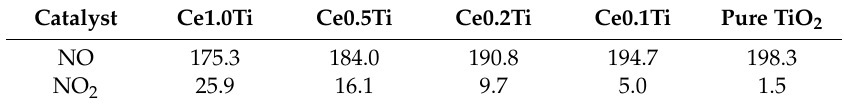
Figure 6. Simultaneous removal of Hg 0 and NO over various catalysts. ( a ) Ce1.0Ti; ( b ) Ce0.5Ti; ( c ) Ce0.2Ti; ( d ) Ce0.1Ti; ( e ) pure TiO 2 . Table 3. The concentrations of NO and NO 2 at the outlet without the existence of NH 3 ( µ L · L − 1 ).